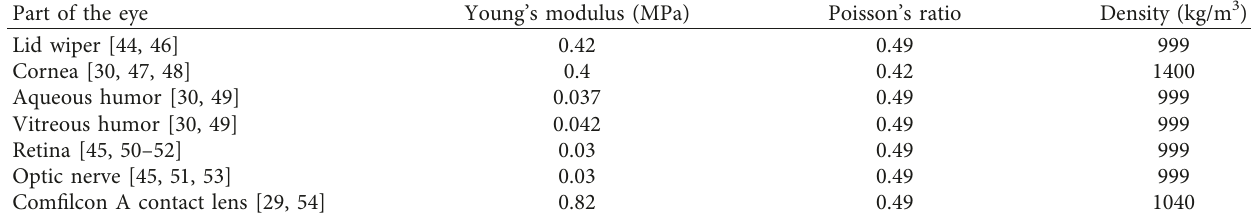
Comfilcon A contact lens [29, 54]